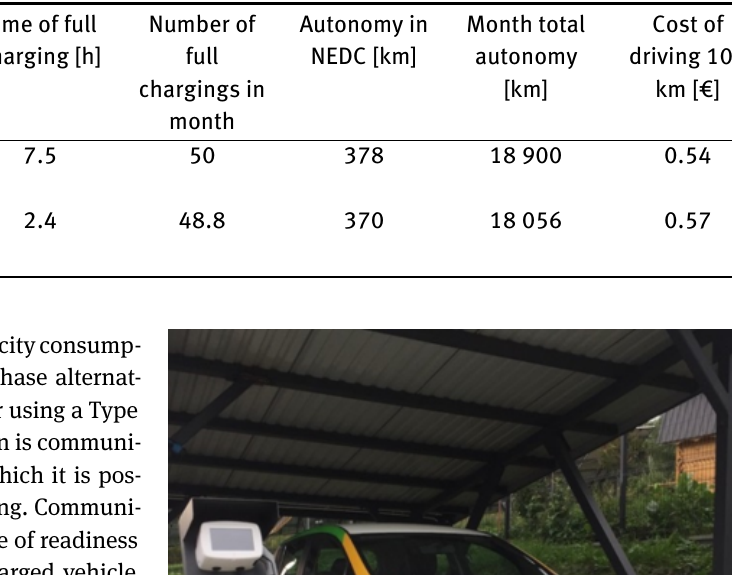
Time of full charging [h]